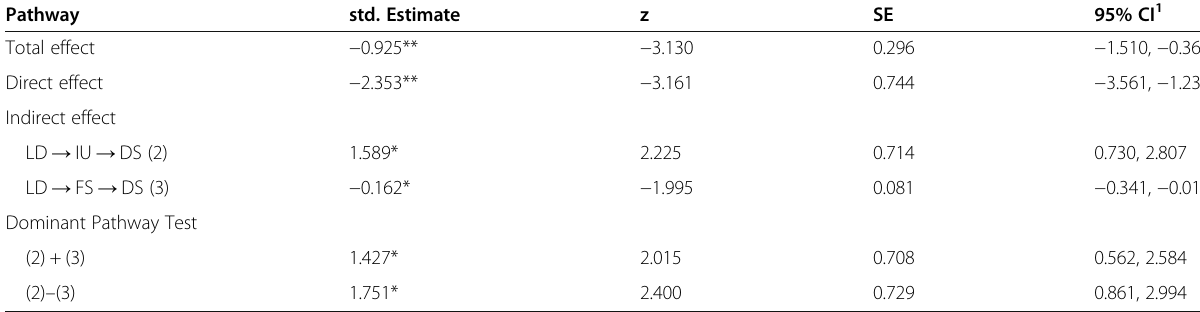
Table 3 coefficients of mediation analysis Pathway std. Estimate z SE 95% CI 1 Total effect